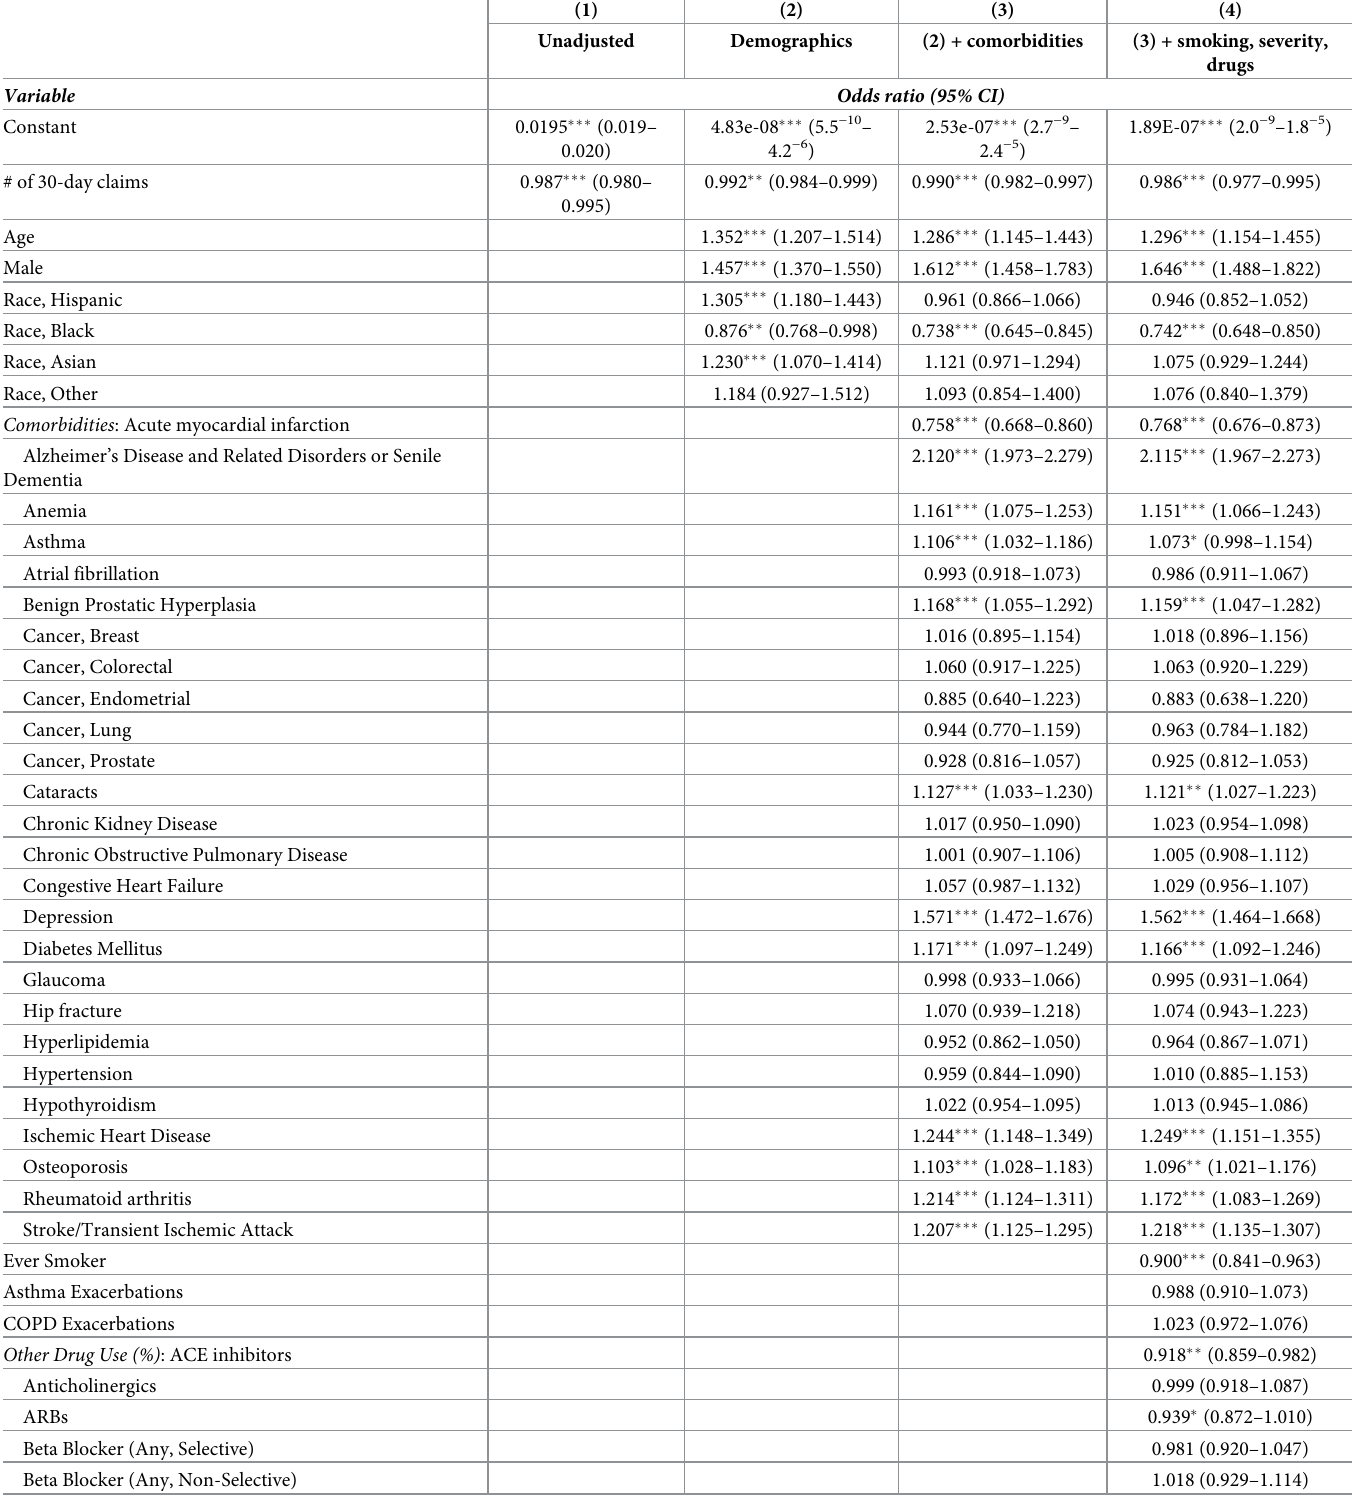
Table 3. Multivariate logistic regression of Parkinson’s disease incidence on β 2-agonist use (30-day